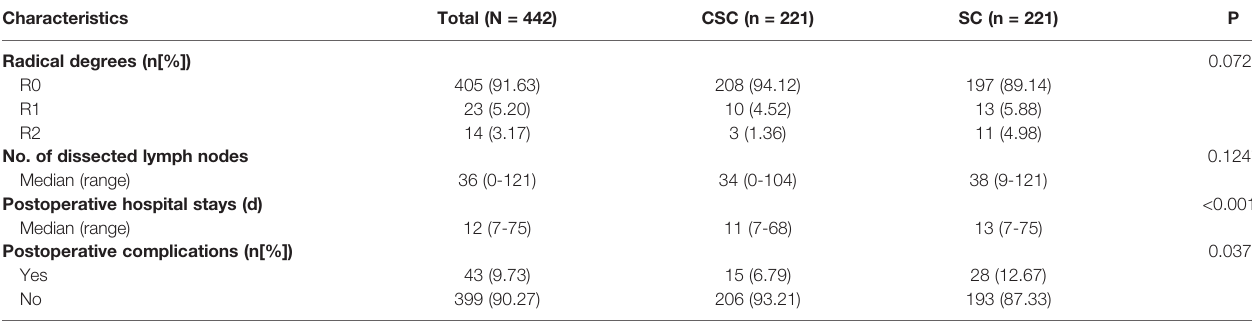
TABLE 4 | Comparison of perioperative outcomes between NAC and S Groups after 1:1 matched. Characteristics